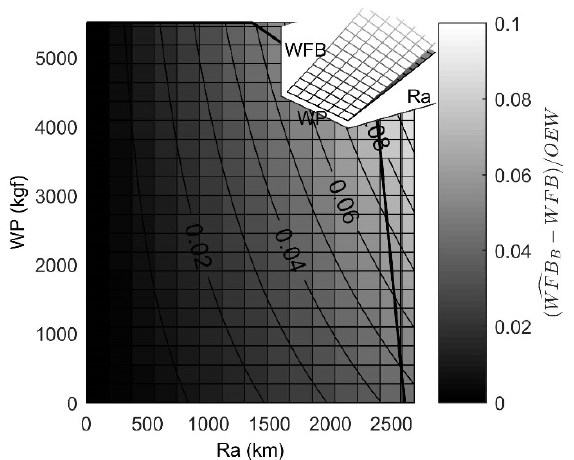
Figure 10. Relative error on the fuel consumption between the estimate with the Breguet range equation WFB(cid:3555) (cid:2886) (Equation (5)) on the same case as in Figure 9. The thumbnail shows the actual unbracketed WFB surface in gray tones and the Breguet estimate WFB(cid:3555) (cid:2886) -surface in shade.